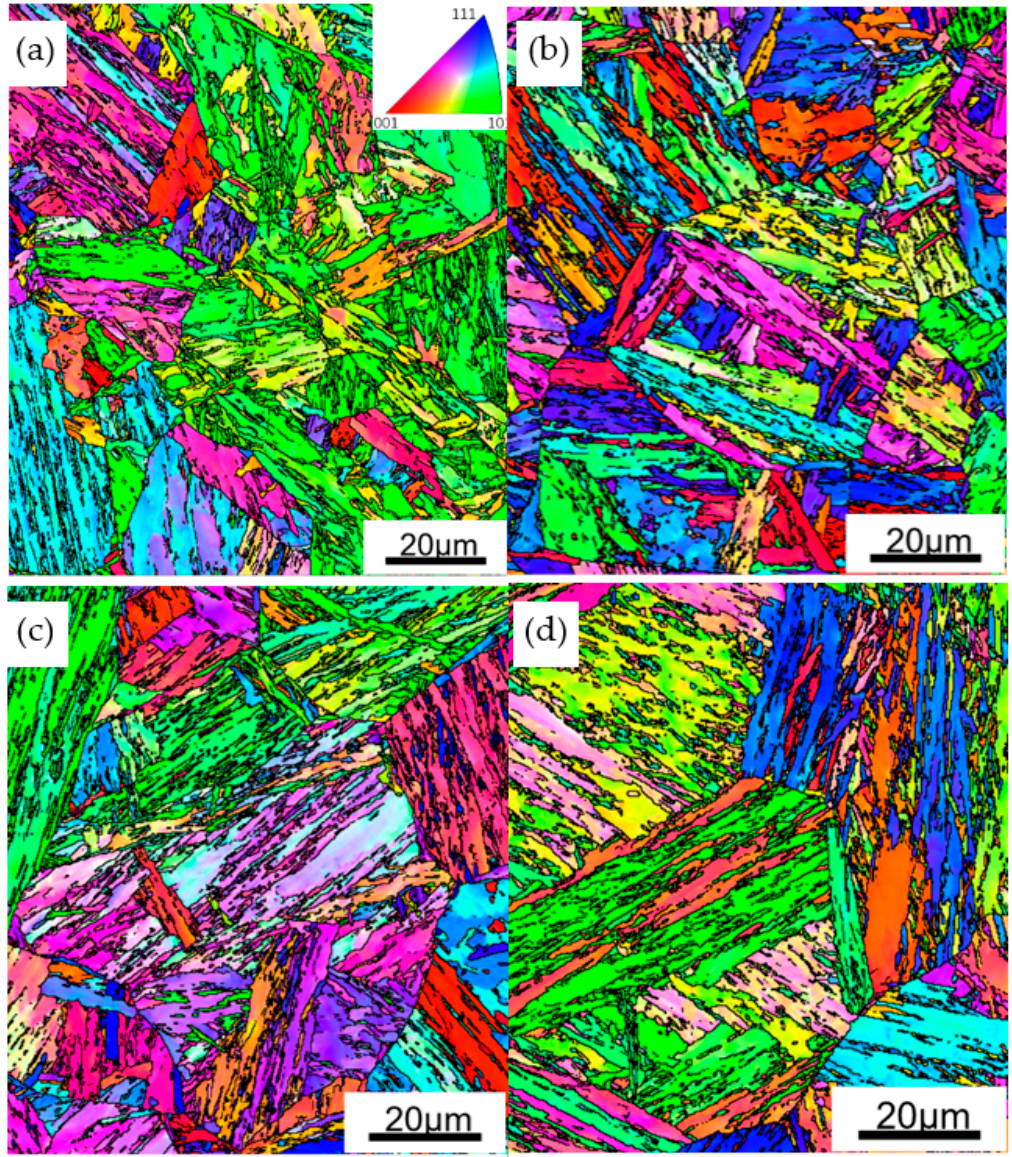
Figure 6. Inverse pole figure maps and boundary distribution (black lines: θ > 5°) as obtained by EBSD of: ( a ) A880; ( b ) A930; ( c ) A1050; and ( d ) A1100.